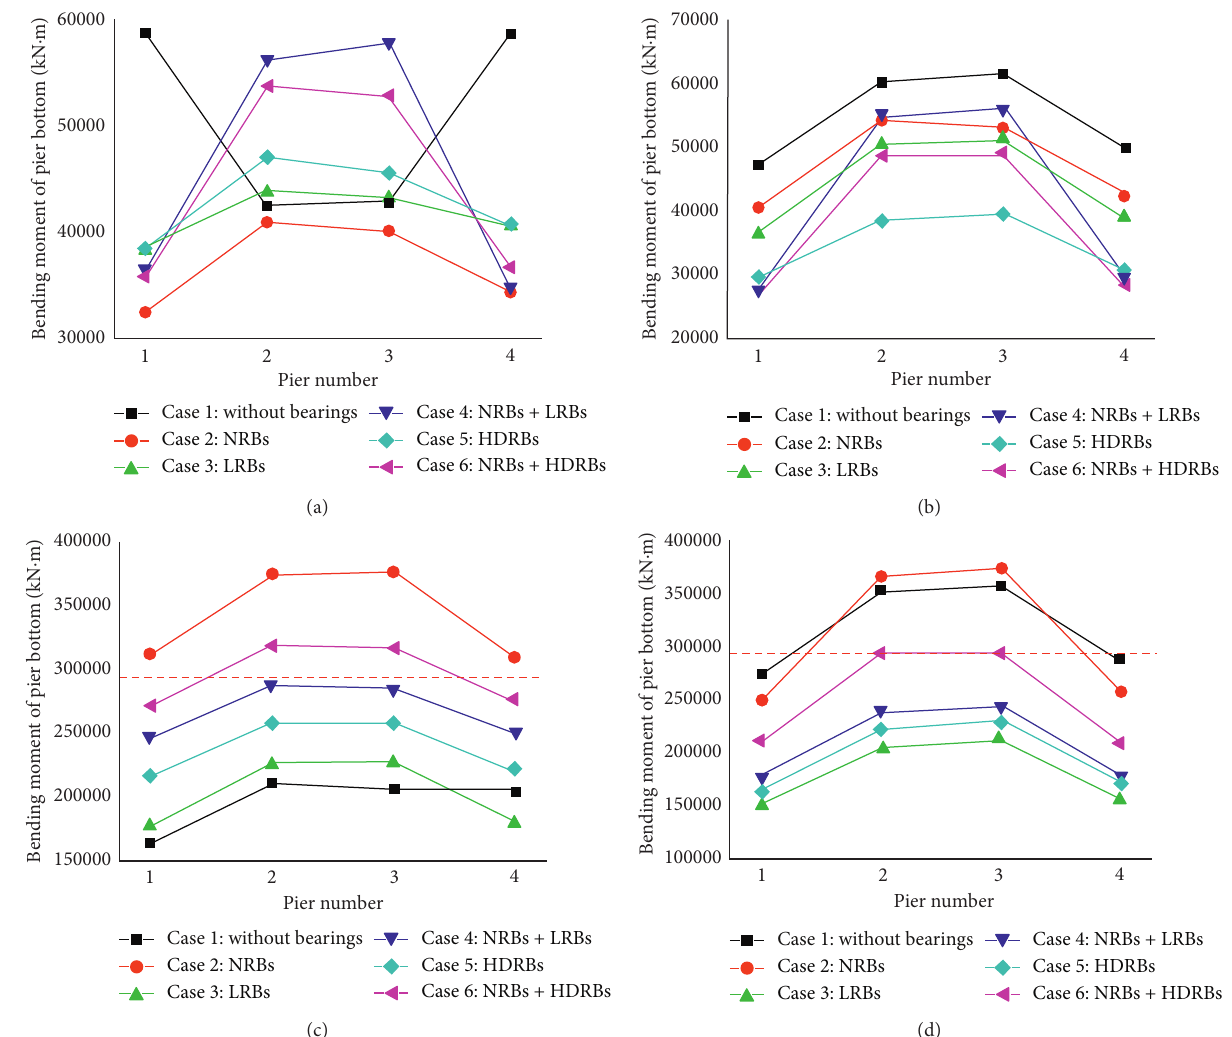
Figure 10: Bending moments of the bottom of the pier in different cases: (a) longitudinal moment under the action of small earthquake; (b) lateral moment under the action of small earthquake; (c) longitudinal moment under the action of large earthquake; (d) lateral moment under the action of large